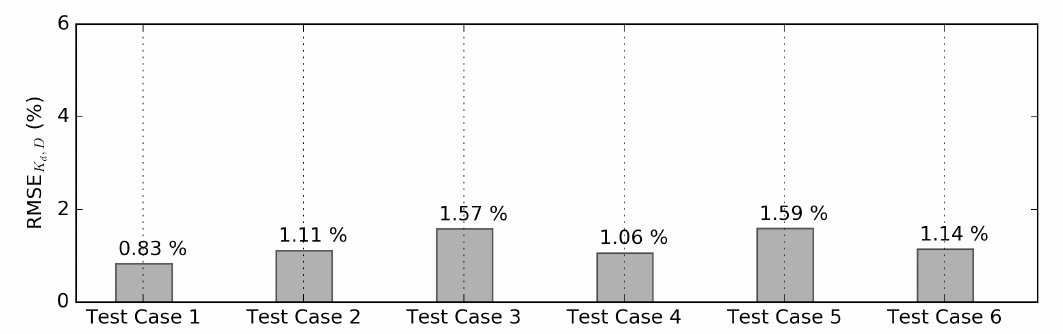
Figure 6. Root-Mean-Square-Error (RMSE) for the K d , RMSE K Comparison between the MILDwave-NEMOH coupled model and NEMOH for all Test Cases of Table 1. 5.3. Comparison between the MILDwave-NEMOH Coupled Model and the WECwakes Experimental